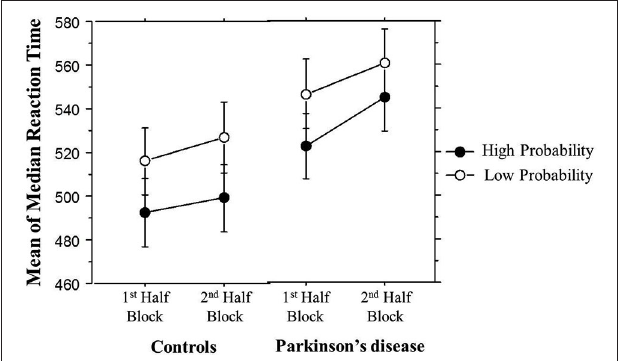
FIGURE 6 | Half Block Triplet type effect (RT to Low Probability triplets – RT to High Probability triplets) by Group and Epoch . Bars indicate standard